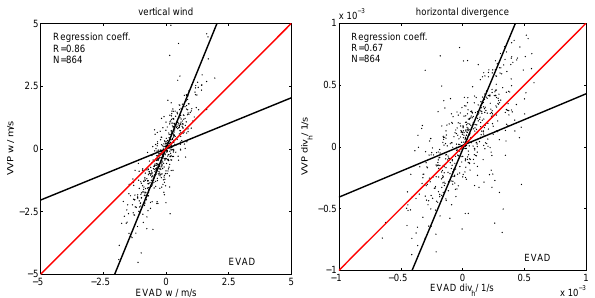
Fig. 8. Scatter plots and correlation coefficients for the vertical wind velocity and horizontal divergence applying a VVP and a EVAD analysis to the measurements. The correlation coefficient and the number of data points are given by the capital letters R and N respectively.